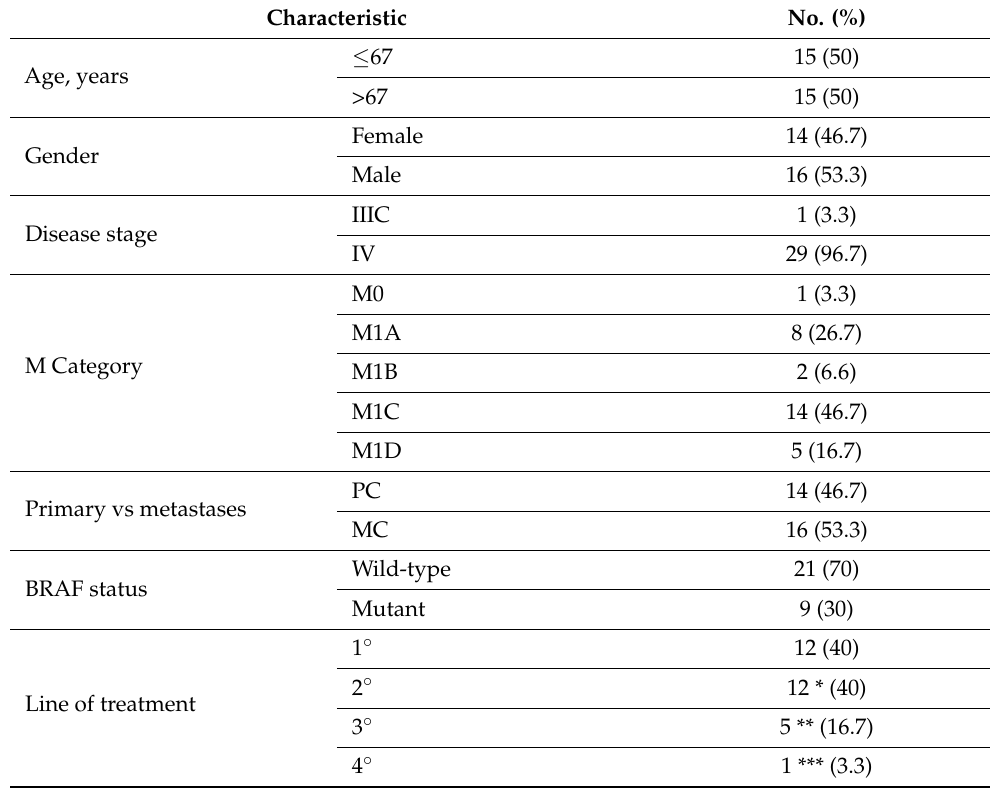
Table 1. Clinical–pathological features of melanoma patients. Thirty melanoma patients treated with nivolumab and their clinical–pathological